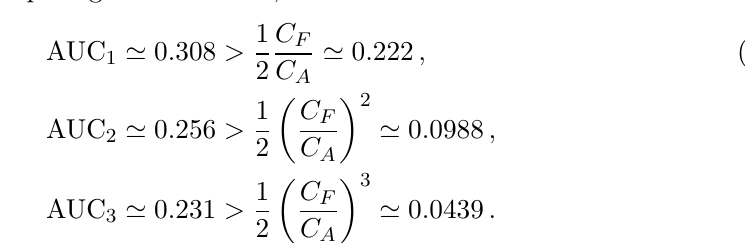
Figure 6. Results of a scan over (cid:11) of the AUC for the observable observable is minimized at (cid:11) =